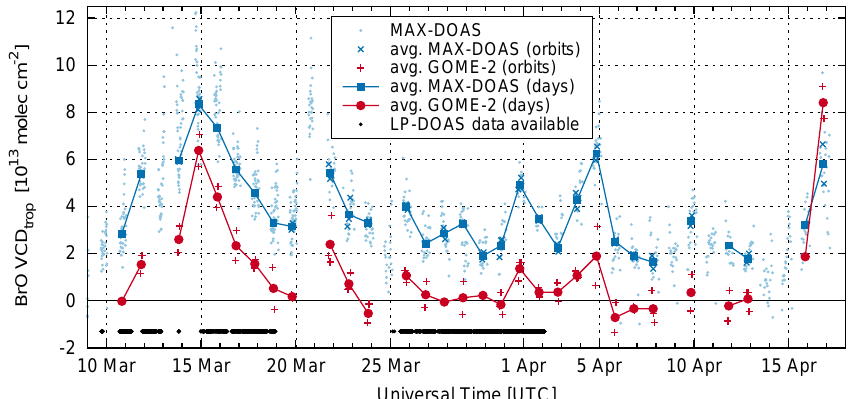
Fig. 13. Time series of MAX-DOAS BrO VCDs from aboard the Amundsen research icebreaker in 2008 compared to retrieved tropospheric = 1), same data as in Fig. 18a. The black dots denote periods of LP-DOAS measurements. Error bars BrO VCDs from GOME-2 (AMF min 500 are omitted for the sake of clarity.